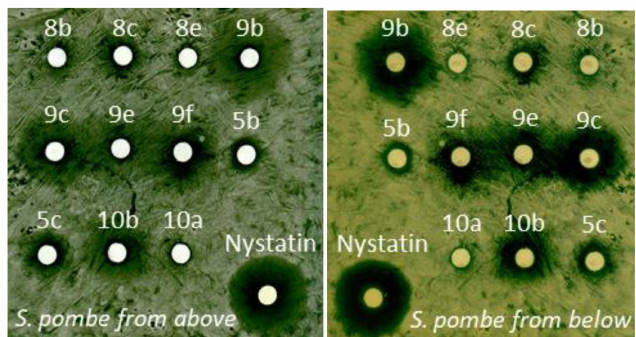
Figure A6. Zones of inhibition for S. pombe spread on agar plates and inoculated at specific points with test compounds; the plate was viewed from above (left) and below